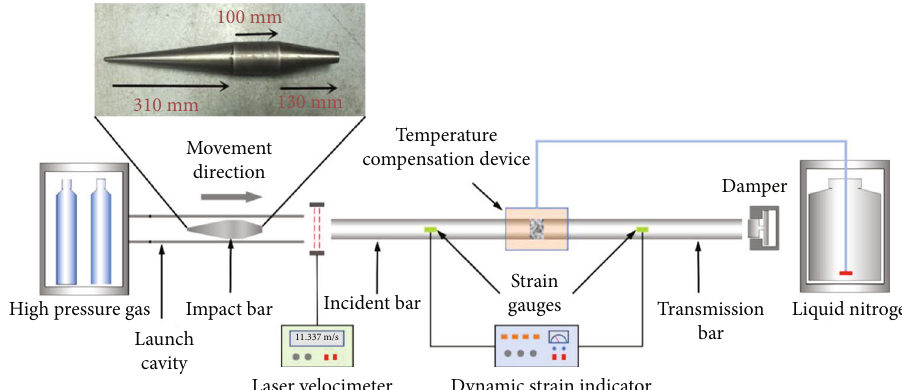
Figure 2: Split Hopkinson pressure bar with a temperature compensation device.